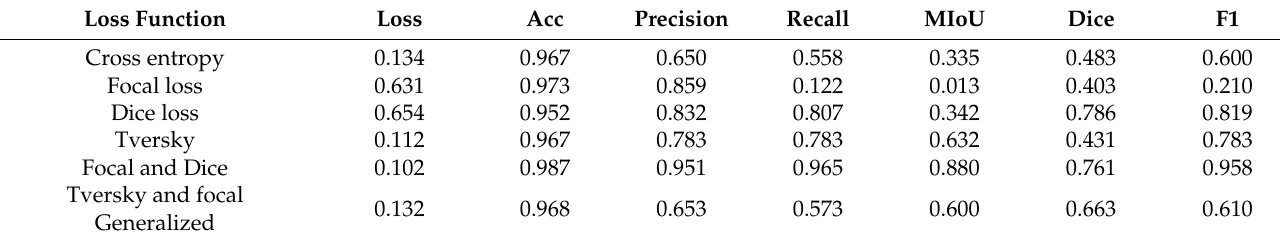
Figure 7. Training losses of different segmentation methods. Table 4. The performance of different loss functions on our